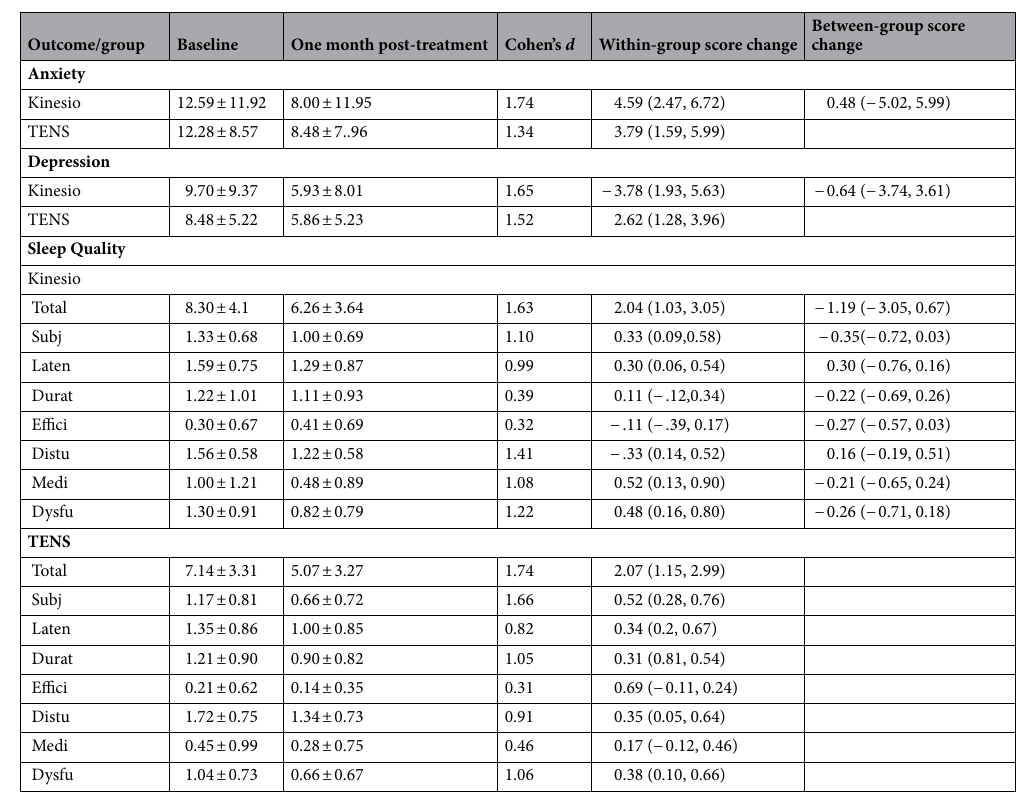
Table 4. Baseline, post-treatment, pre-post-treatment differences and change scores in each group (95% confidence interval) for mental health and sleep quality. Values are expressed as means ± standard deviation for baseline and 1 month post− treatment and as mean (95% confidence interval) for within- and between- group change scores. Anxiety beck’s anxiety inventory, Depression beck’s depression inventory, Sleep Quality the pittsburgh sleep quality index, Subj subjective sleep quality, Laten sleep latency, Durat sleep duration, Effici habitual sleep efficiency, Distu sleep disturbances, Medi use of sleep medications, Dysfu diurnal